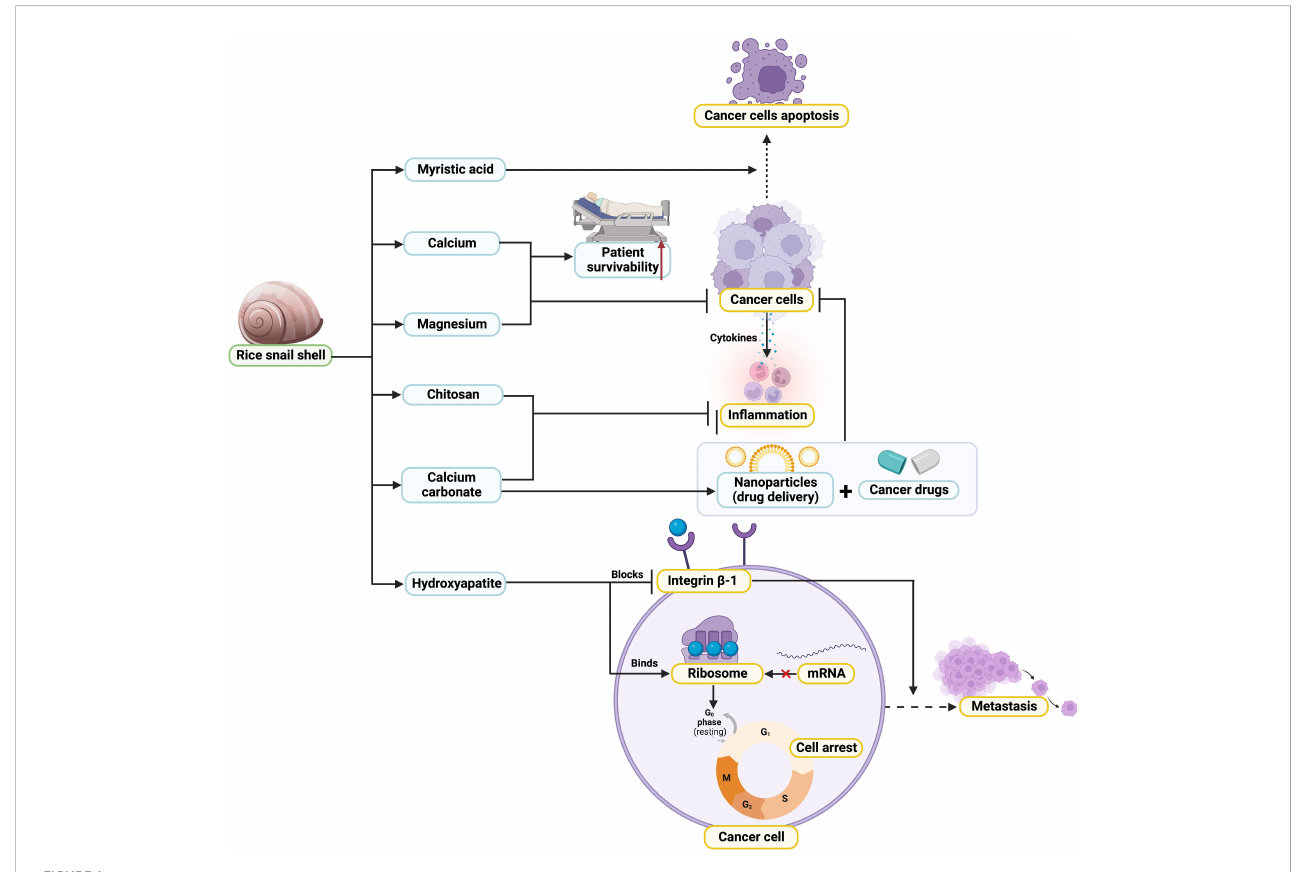
FIGURE 1 Possible mechanistic of anticancer properties of rice snail